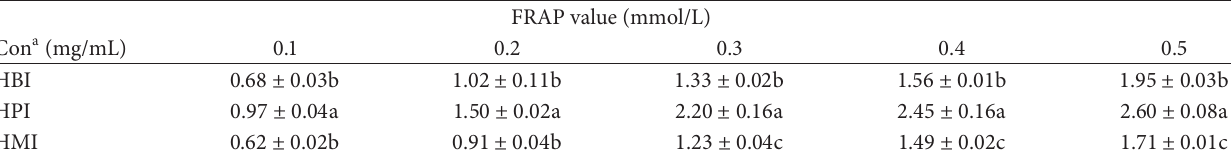
Table 3: FRAP value of HMI, HPI, and HBI. Each value is the mean ±